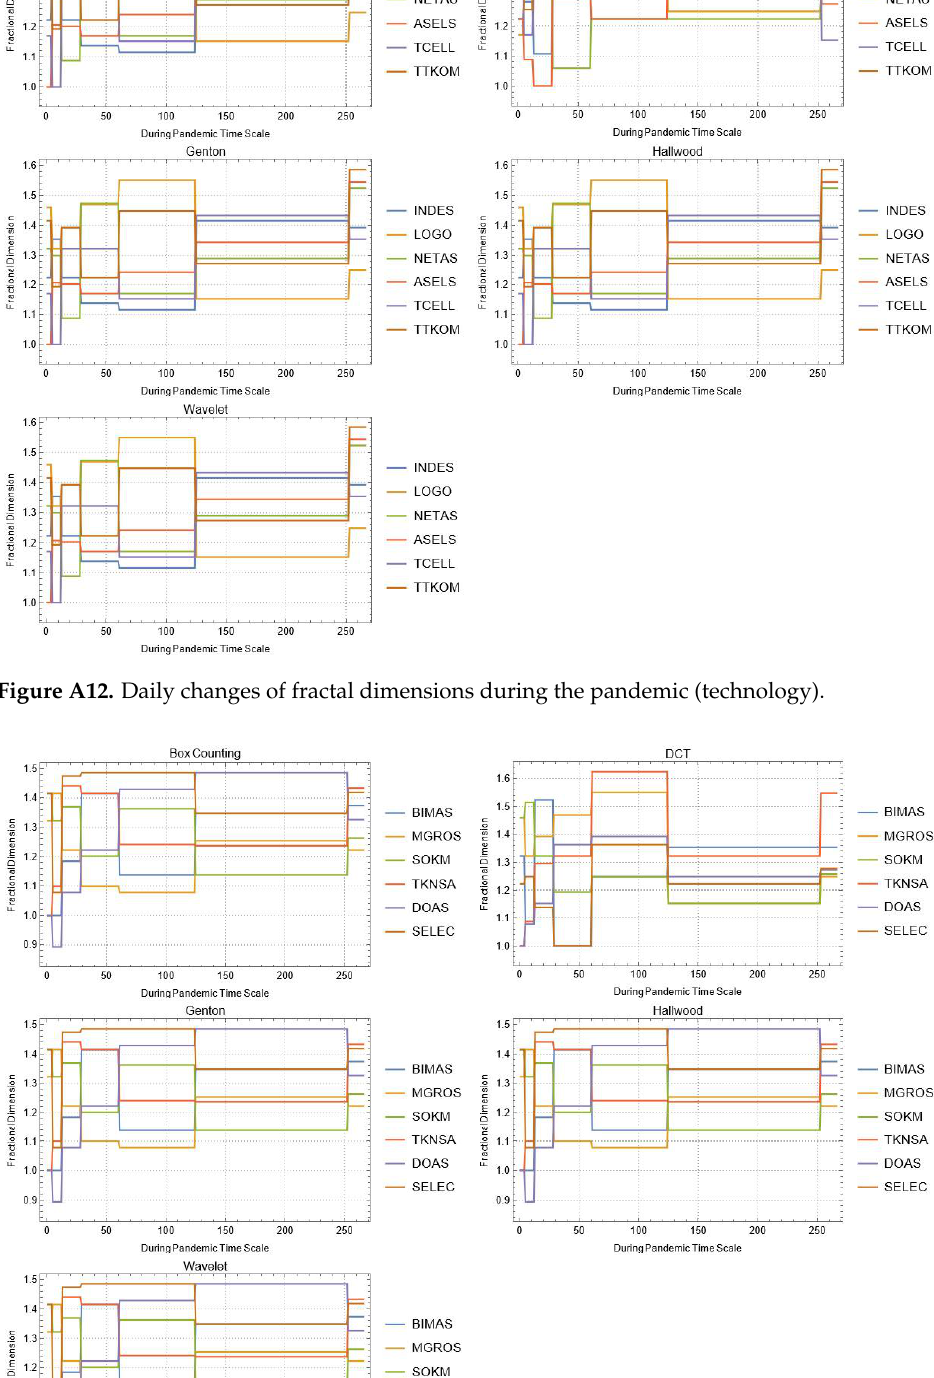
Figure A11. Daily changes of fractal dimensions during the pandemic (holdings–investment companies).